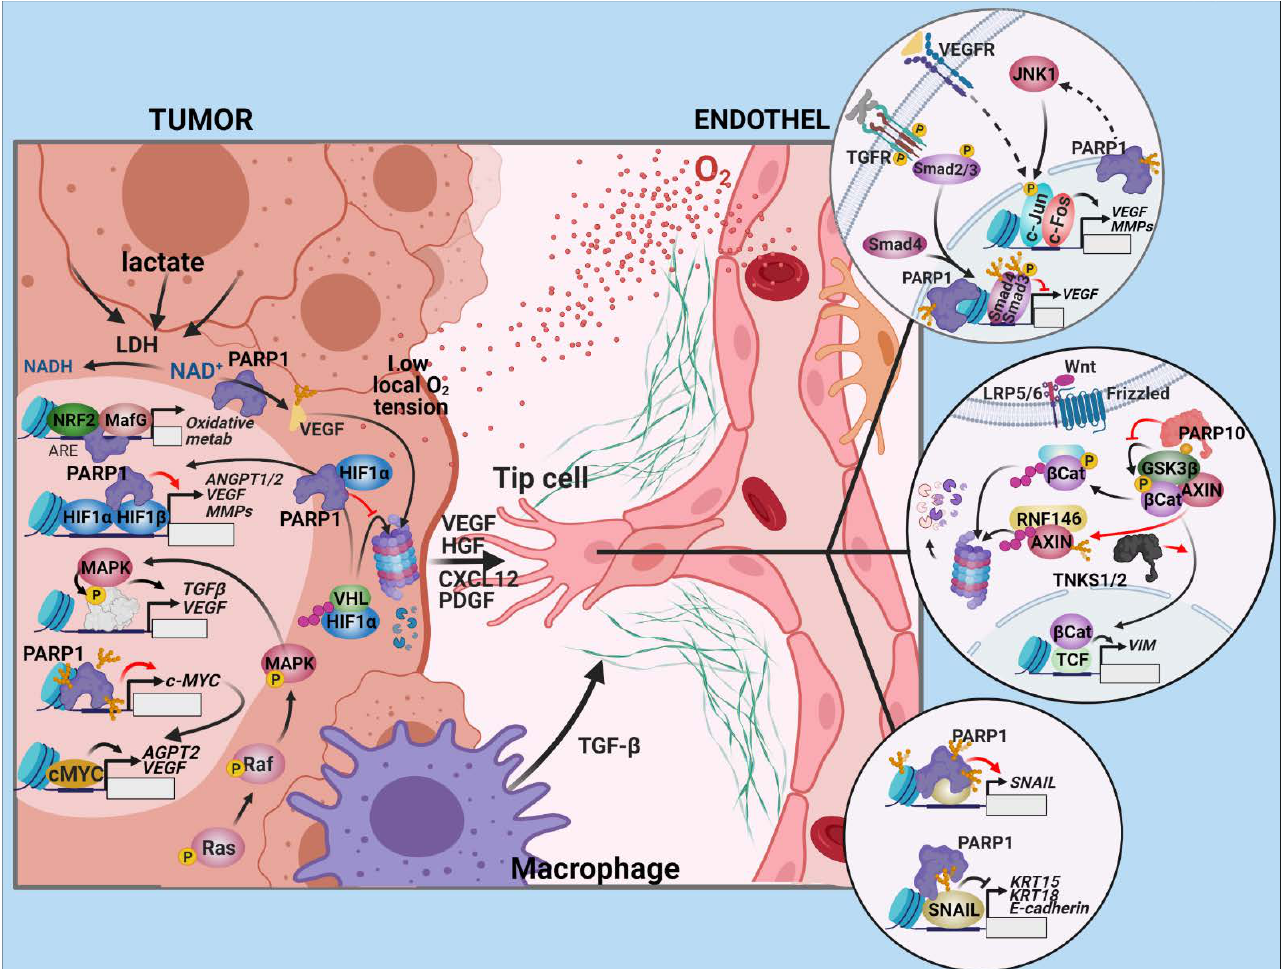
Figure 1. The contribution of PARPs to tumor angiogenesis. Angiogenesis is mainly promoted by low oxygen tension and altered metabolism in the interior of solid tumors. The response in cancer and the endothelial cells is primarily mediated by HIFs, which upregulate an array of angiogenesis-stimulating genes (e.g., VEGF, ANGPT2, CXCL12, HGF, PDGF-B). PARP-1 protects HIF1 and HIF2 from VHL-mediated ubiquitylation and proteasomal degradation, and also functions as a transcriptional co-activator for both. NRF2 stimulates mitochondrial oxygen consumption and enhances HIF1 activation by further reducing the intracellular O 2 level. Although VEGF and VEGF2 are destabilized by PARylation, they can be preserved within the tumor because lactate, produced in excess by poorly oxygenized cancer cells with a rewired metab- olism, reduces the NAD + available for PARylation. PARP-1 also licenses the expression of c-MYC, another angiogenesis- related factor. The formation of new blood vessels begins with the EndoMT of a few endothelial cells in the vascular bed of the tumor site. The loss of apical-basal polarity and the adoption of a migratory phenotype, together with changes in molecular markers, are promoted by the TGF- β and WNT/β -catenin pathways (upper and middle callout circles). TNKS1/2 activate β -catenin by PARylating and targeting AXIN for proteasomal degradation. PARP- 10 also stimulates β -catenin by MARylation- mediated inactivation of GSK3β, another negative regulator of WNT/β -catenin signaling. VEGF-stimulated endothelial cell migration depends on AP-1 signaling, and PARP-1 supports the AP-1 transcriptional response by activat- ing JNK (upper callout circle). PARP-1 is involved at multiple levels in the positive regulation of SNAIL1, one of the most important transcription factors driving EndoMT (bottom callout circle). VIM: vimentin, KRT15/18: keratin 15/18.